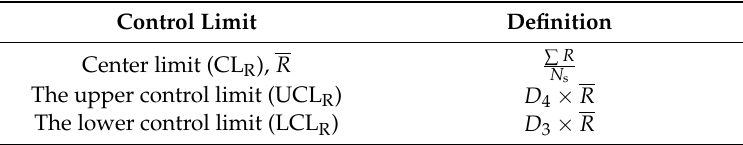
Table 3. Definitions for R -chart. R is the range between selected frictional forces. N s denotes number of subgroups. D 3 and D 4 denote the constants, and they were zero and 3.267, respectively.